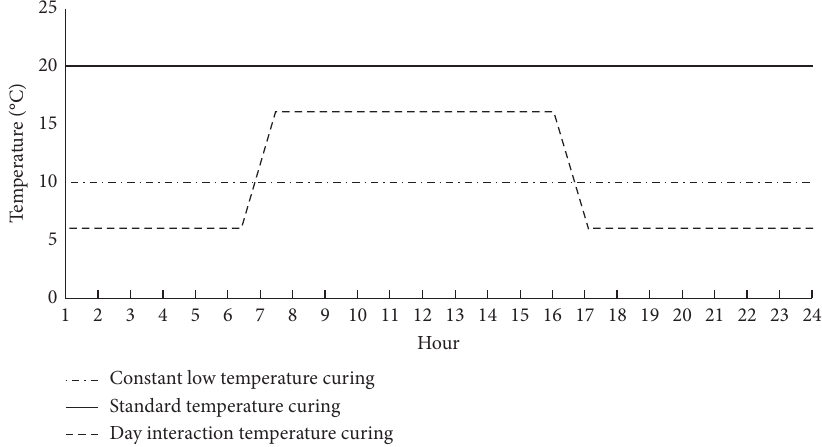
Figure 3: Temperature schematic diagram of three indoor testing